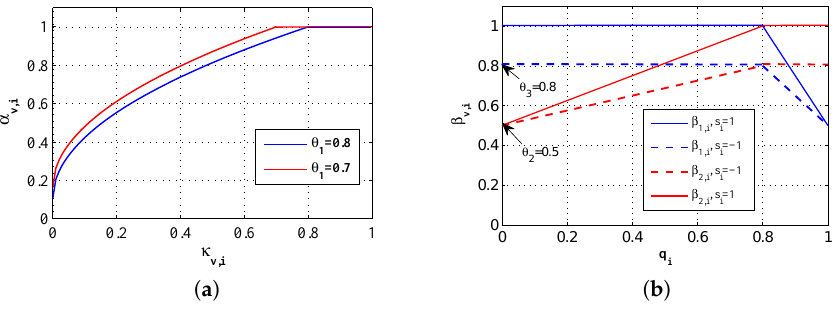
Figure 5. Distribution characteristics α v , i of and β v , i . ( a ) α v , i with θ 1 = 0.8 or θ 1 = 0.7; ( b ) β v , i with θ 2 = 0.5 and θ 3 =